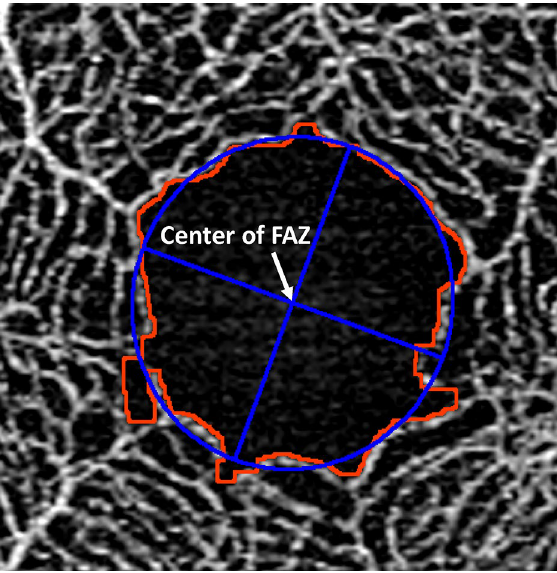
Figure 1. Identification of the center of the foveal avascular zone. The central fossa vessel-free zone was extracted using the Kanno–Saitama Macro (KSM) method (red line). An approximate ellipse was created for the delineated foveal avascular zone (FAZ) (blue line). The center of the FAZ is defined as the intersection of the major and minor axes of the approximate ellipse. This figure was created using SS-OCTA (PlexElite9000 Carl Zeiss Meditec, Jena, Germany) and ImageJ software.